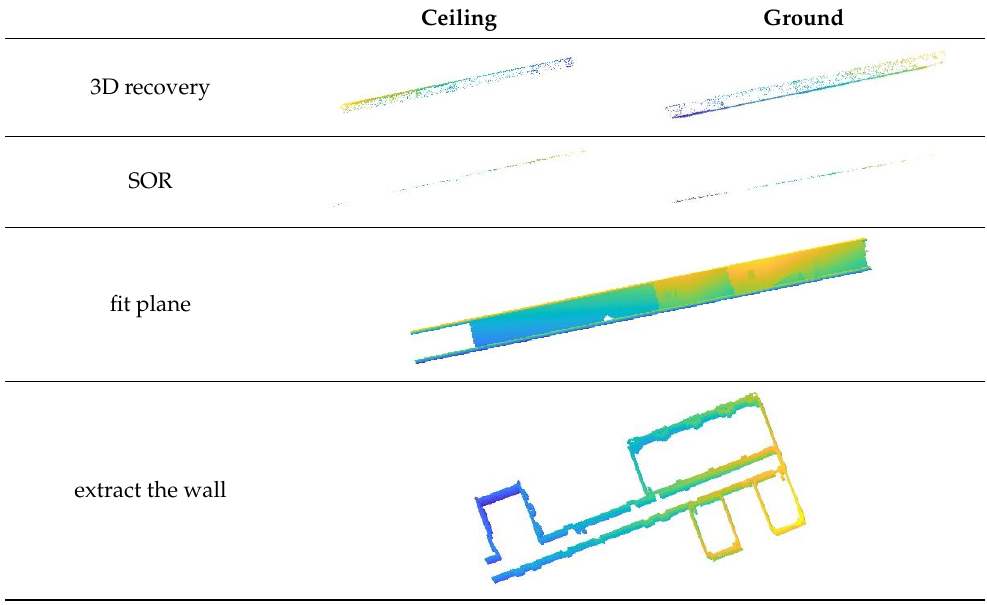
extract the wall